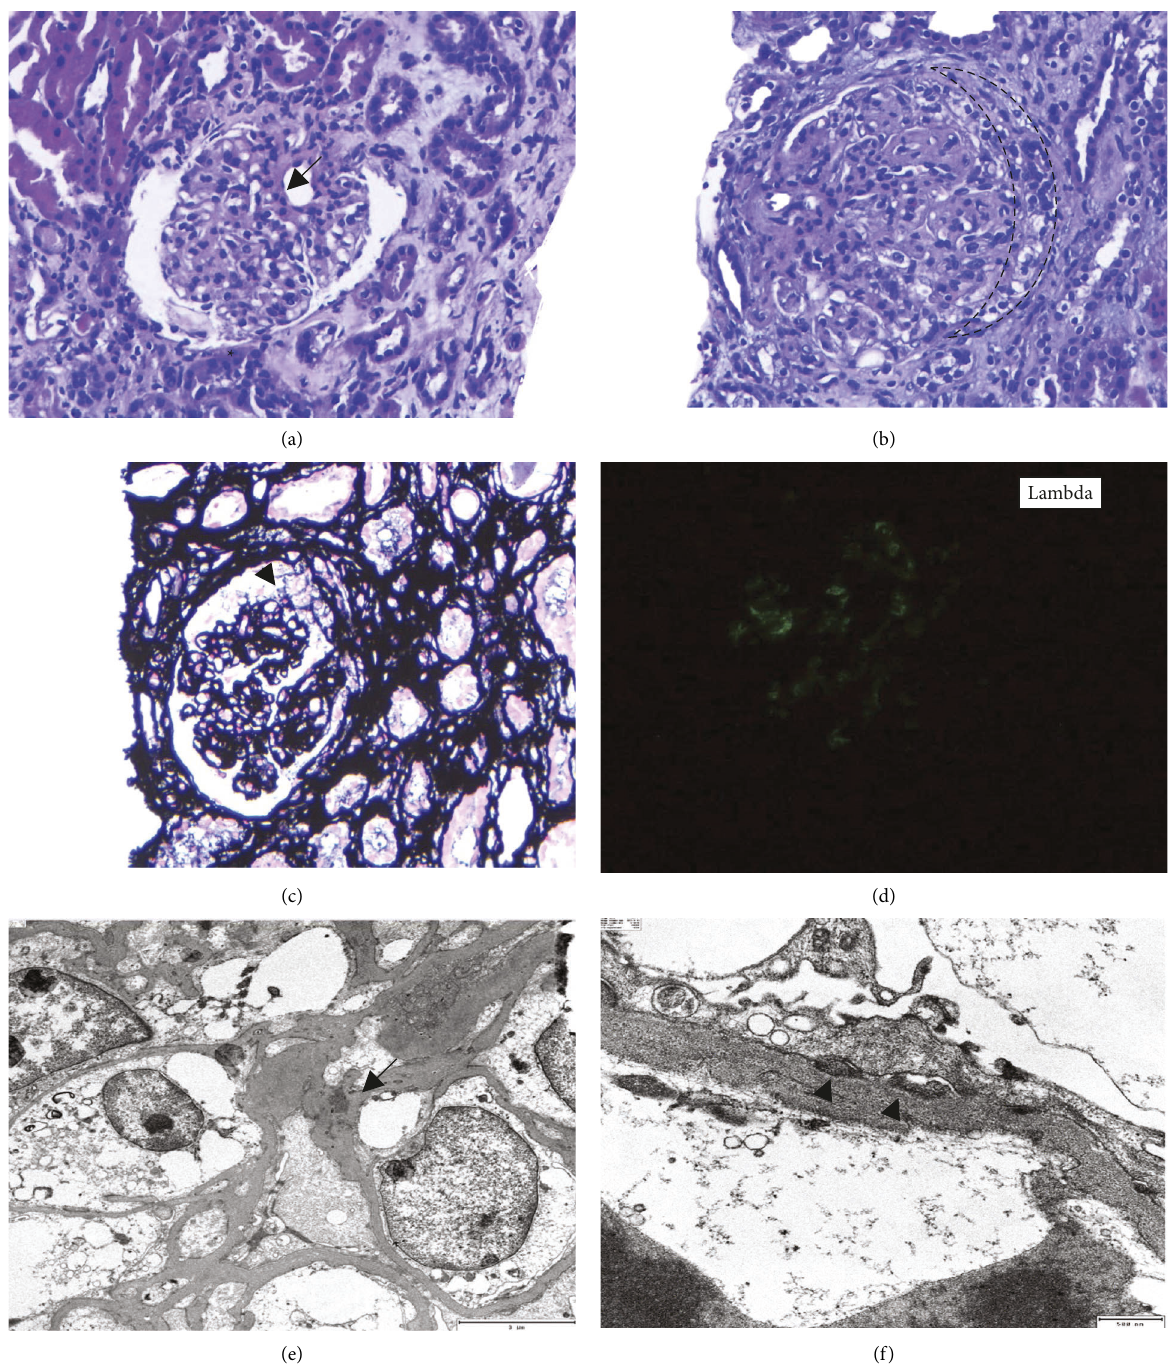
Figure 1: Light microscopy shows a global increase of mesangial matrix, with focally mesangial hypercellularity (arrow). (a) Hyalinosis of the afferent arteriole was observed (asterisk) ( H - E , 200 x ). (b) The glomerulus shows irregular capillary wall thickening and a cellular crescent (dashed crescent) ( H - E , 200 x ). (c) Methanamine-silver stain (200x) shows a glomerulus with a cellular crescent (arrowhead). (d) Direct immunofluorescence showing bright granular staining of glomerular mesangium for lambda light chain (lambda++/kappa+, 200 x ). (e) Electron microscopy revealed large electron-dense nonorganized deposits in mesangial areas (arrow) (10000 x ). (f) Electron microscopy showing segmental subendothelial mesangial deposits (arrow-head) (10000 x